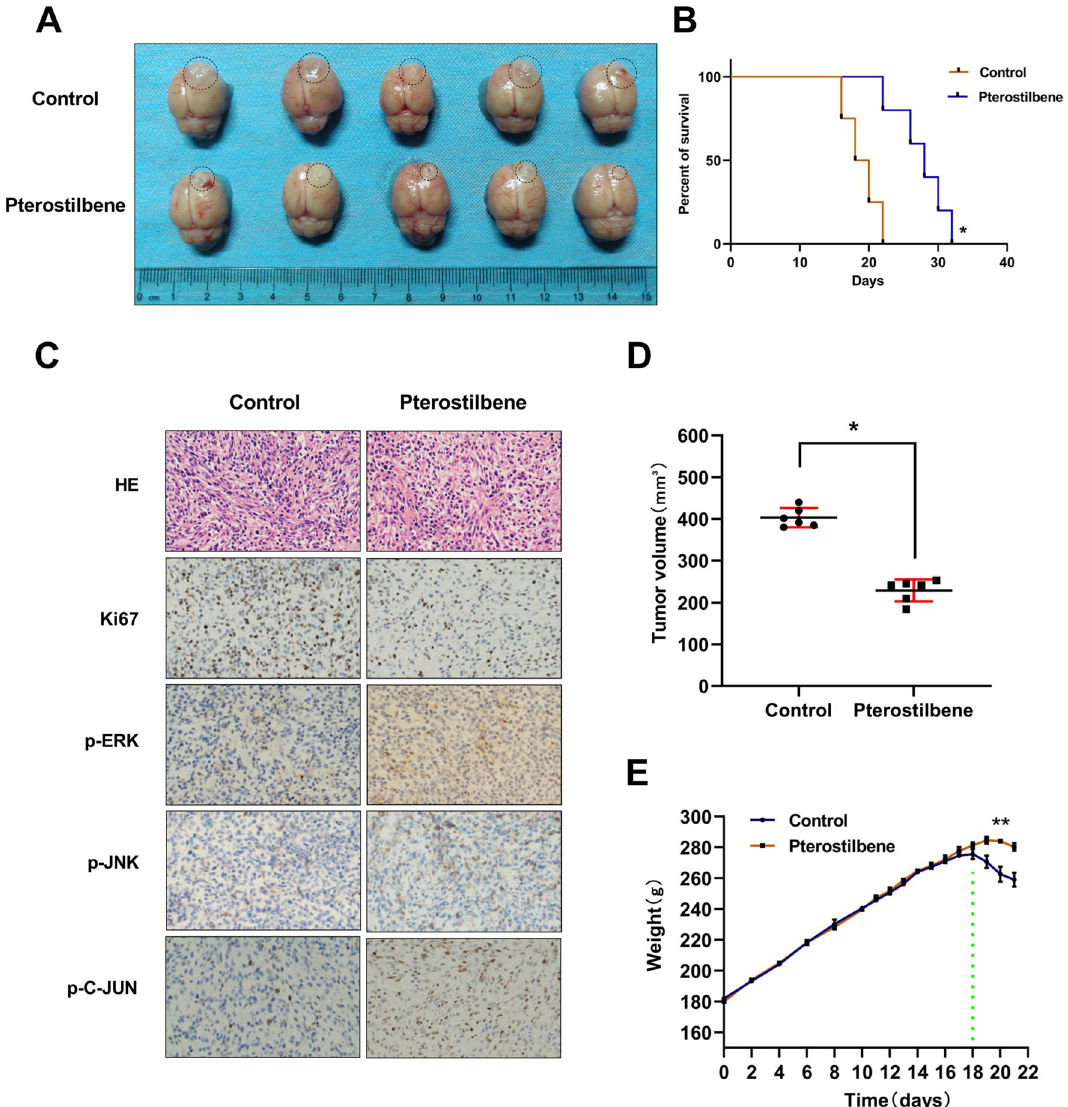
Figure 7. Pterostilbene inhibited the growth of glioma in vivo. ( A ) Tumor samples were collected and photographs show tumor volume in different groups. ( B ) Survival of brain tumor bearing rats were recorded and represented in a Kaplan–Meier plot. ( C ) The intracranial tumor tissues were stained with HE and immunohistochemistry analysis using anti-Ki-67, anti-p-ERK1/2, p-JNK, p–C-JUN antibodies. Positive staining of the cells is brown. ( D ) Tumor volumes in control groups and PTE treatment groups. The tumor volume was calculated using formula: 0.5 × A × B 2 , which A was the length of the tumor and B was the width. ( E ) Rat body weights were measured for 21 days. Data are presented as the mean ± standard deviation (SD); n = 3; * p < 0.05, ** p < 0.01, compared with the vehicle control Transwell and wound healing assays. 24-well Matrigel-coated Transwell invasion assay (8 μm pore size, Millipore, Darmstadt, Germany) was used to assess the invasion capability of glioma cells. Suspension of cells (2 × 10 4 /200 μL) with serum-free medium and various concentrations of PTE then plated on the top side of the membrane coated with Matrigel (BD) and incubated at 37 °C for 48 h. Cells that crossed to the underside of the Transwell membrane were stained with 0.1% crystal violet, then observed and photographed under an inverted microscope (Olympus IX53/DP80). Wound healing assays was used to monitor the migration capacity of glioma cells. Briefly, cells (2 × 10 5 cells/ well) were seeded in 6-well plates. When the cells reached 90% confluence, we used the end of a 10-μl steriled micropipette tip to make a scratch. The tip was moved vertically downward on the 6-well plate to ensure that a consistent wide scratch. Then the cells were washed 3 times with PBS and cultured with serum-free medium. Images of scratches were used to monitor the migration of cells to the cleared zone at 0, 24, and 48 h after treat- ment with various concentrations of PTE using a microscope equipped with a camera (Olympus IX53/DP80).